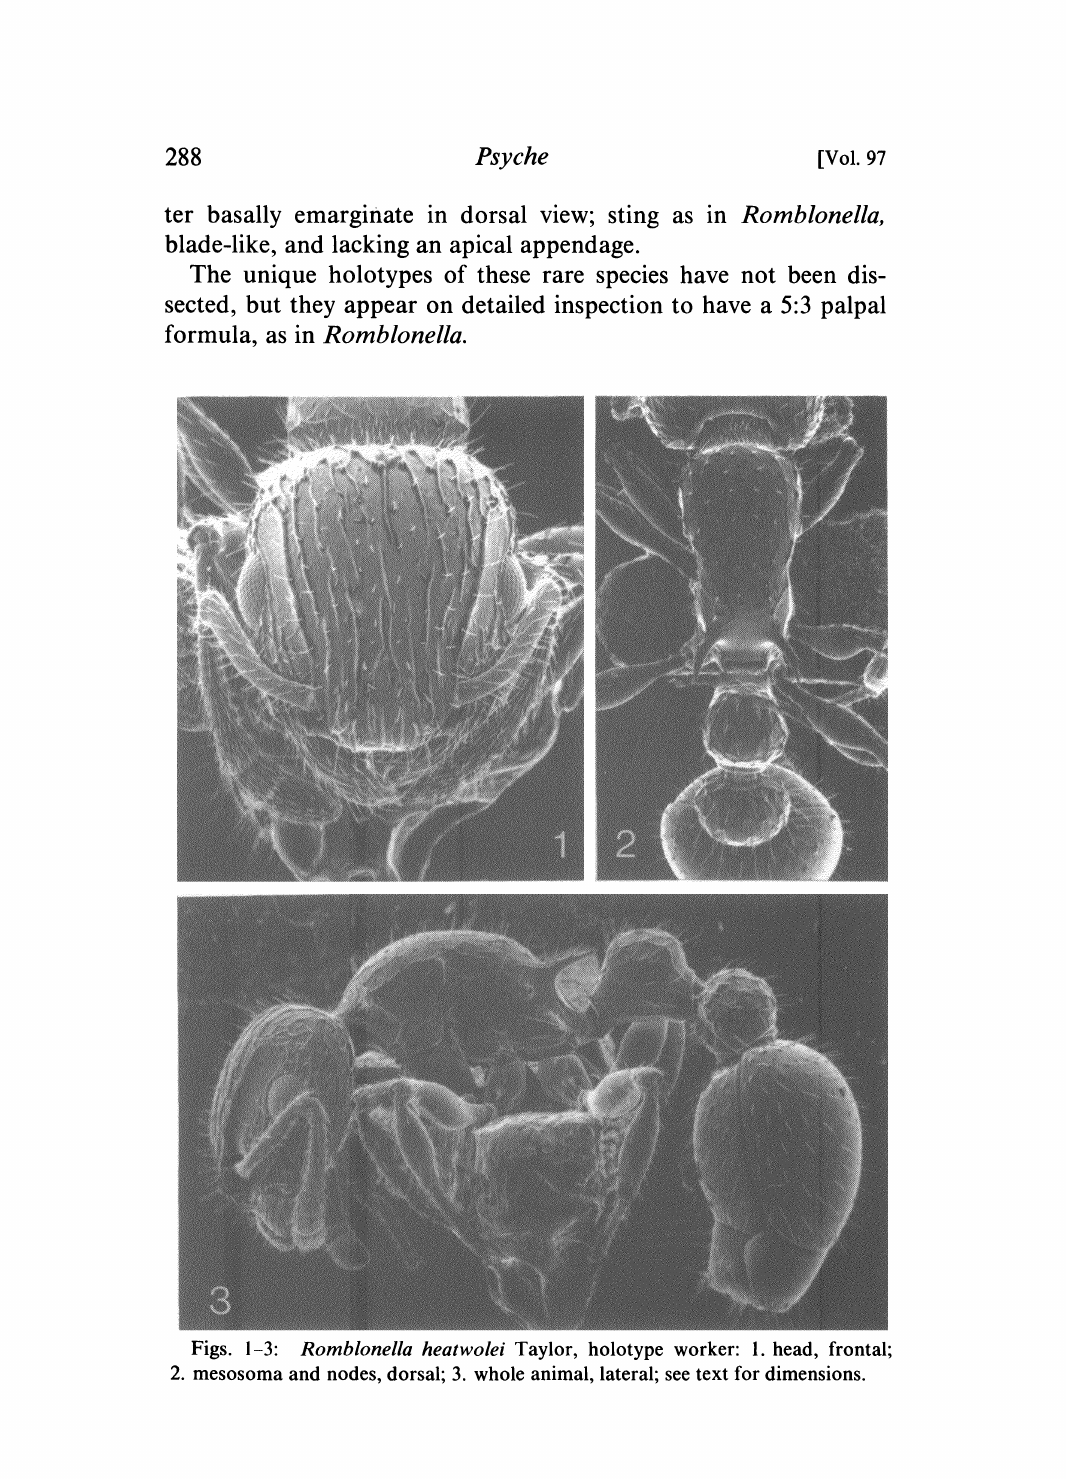
Figs. 1-3: Romblonella heatwolei Taylor, holotype worker: 1. head, frontal; 2. mesosoma and nodes, dorsal; 3. whole animal, lateral; see text for